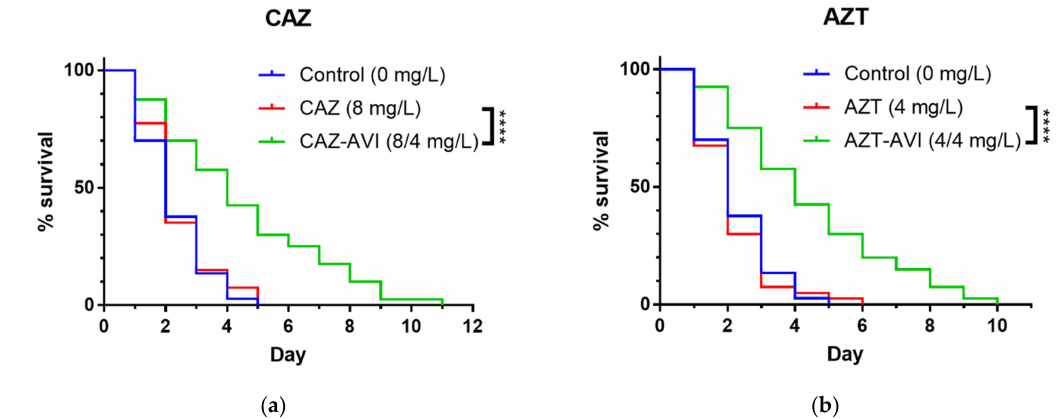
Figure 6. C. elegans survival curves. Infected nematodes ( n = 40) were treated with (a) ceftazidime or ceftazidime with avibactam, (b) aztreonam or aztreonam with avibactam. Nematodes were consistently treated with avibactam at a concentration of 4 mg/L. Abbreviations: CAZ, ceftazidime; CAZ-AVI, ceftazidime with avibactam; AZT, aztreonam; AZT-AVI, aztreonam with avibactam. ****, p < 0.0001.